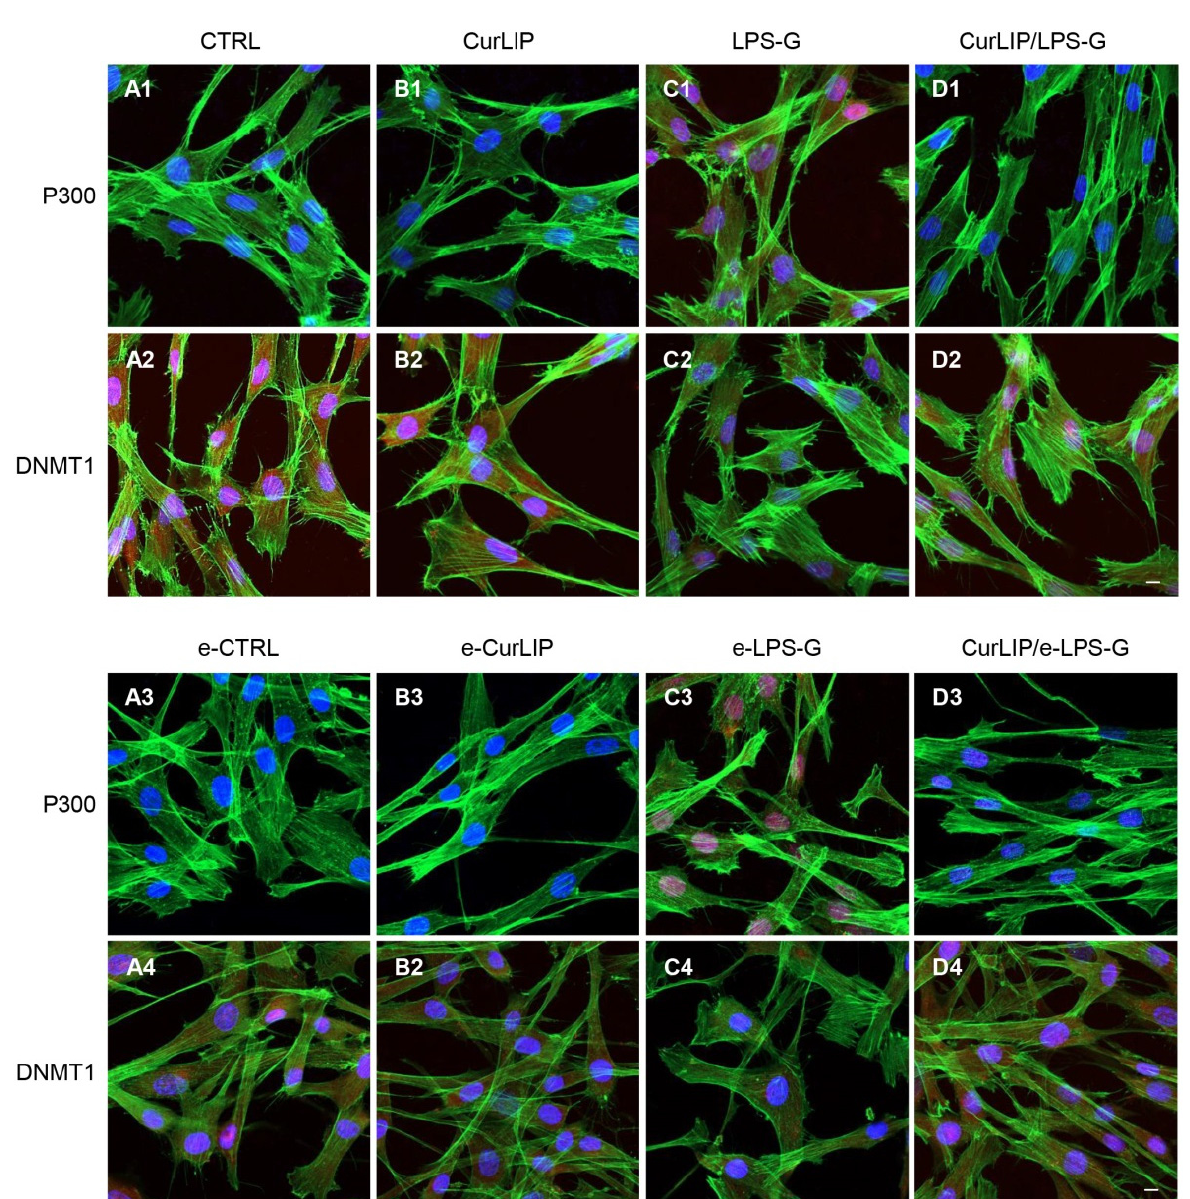
Figure 5. DNMT1 and p300 expression in hPDLSCs and e-hPDLSCs. The localization of DNMT1 and p300 was determined by immunofluorescence in all considered sample groups. Positive cells showed the protein expression in red, the cytoskeleton actin was marked in green and cell nuclei were stained with TOPRO in blue. ( A1 – D1 ) p300 expression in CTRL, CurLIP, LPS-G and CurLIP/LPS-G. ( A2 – D2 ) DNMT1 expression in CTRL, CurLIP, LPS-G and CurLIP/LPS-G. ( A3 – D3 ) p300 expression in e-CTRL, e-CurLIP, e-LPS-G and CurLIP/e-LPS-G. ( A4 – D4 ) DNMT1 expression in e-CTRL, e-CurLIP, e-LPS-G and CurLIP/e-LPS-G. Scale bar = 10 µm.